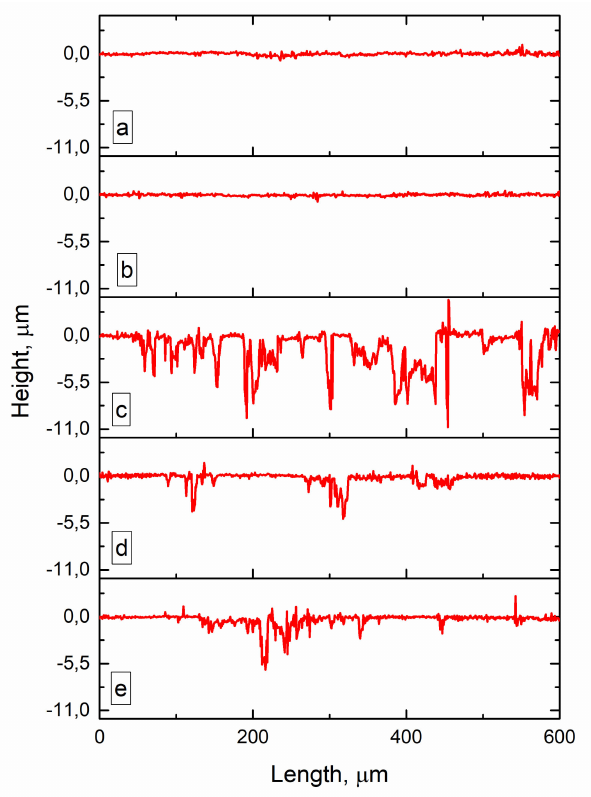
Figure 18. The surface profiles after corrosion according to zones shown in Figure 15. As-deposited AA4047 zones ( a , b ), transition zone ( c ), heat-affected AA7075 ( d ), as-received AA7075-T42 ( e